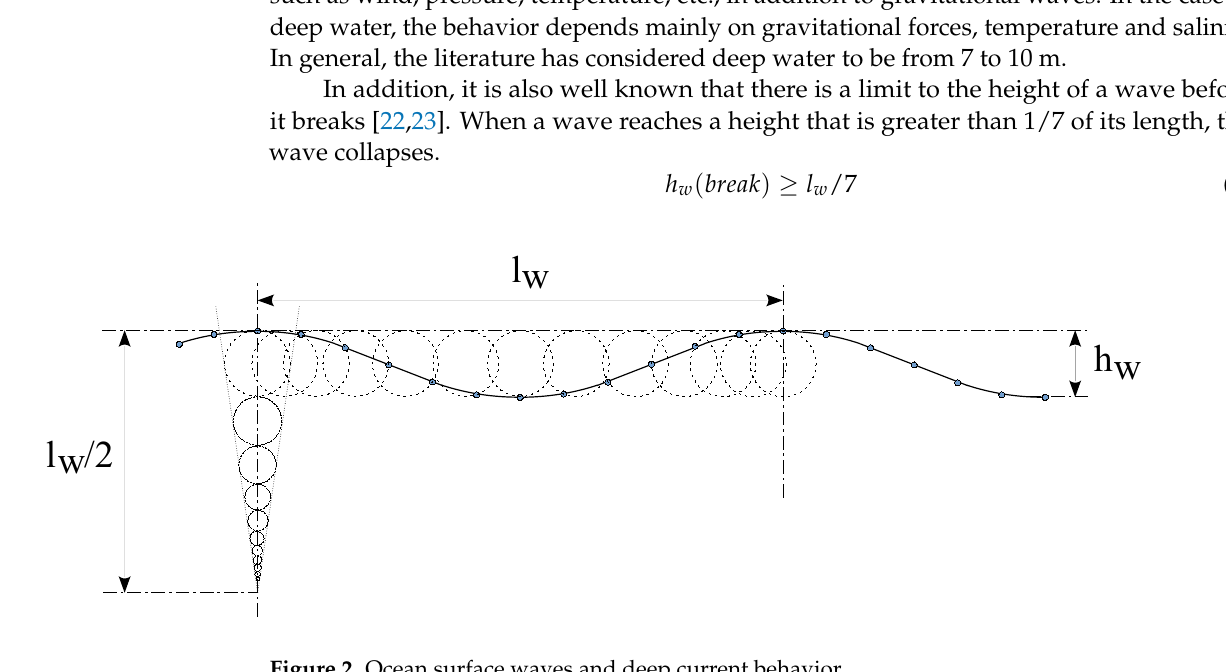
Figure 2. Ocean surface waves and deep current behavior.